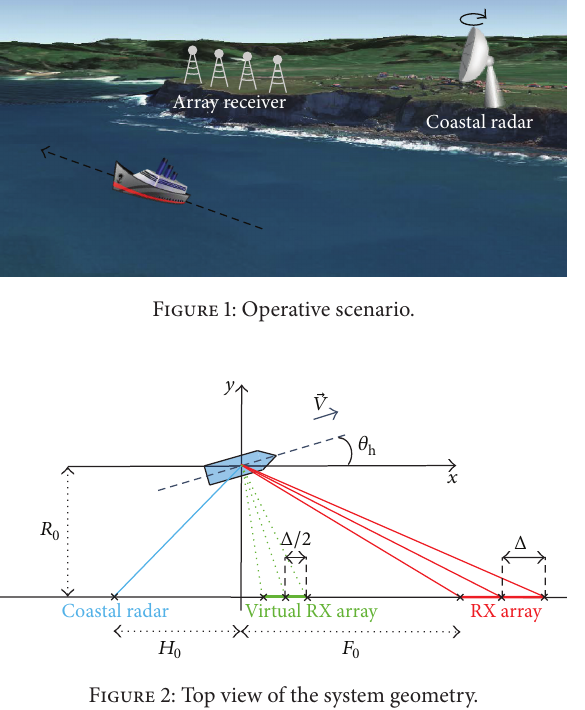
Figure 2: Top view of the system